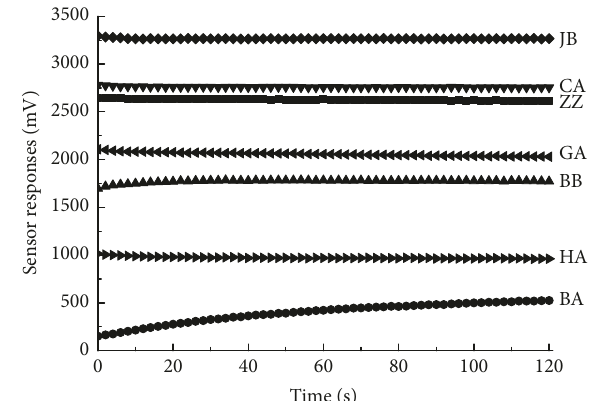
Figure 2: Typical response of E-tongue sensors to taste substance of minced mutton adulterated with 40% of pork (ZZ: ; BA: ; BB: ;